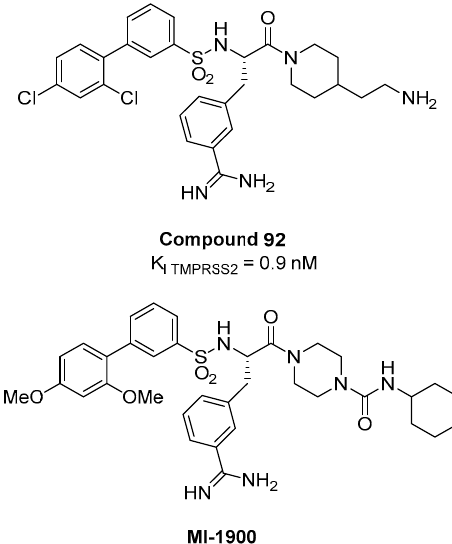
Figure 13. Substrate analogues containing 3-amidinophenylalanine as P1 residue as TMPRSS2 inhibitors compound 92 and MI-1900 showing antiviral activity against SARS-CoV-2.